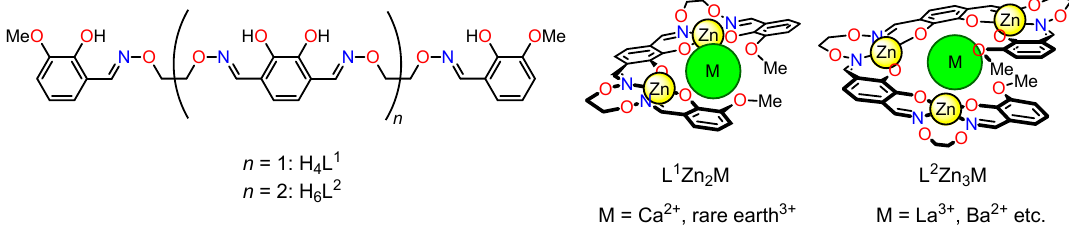
Figure 6. Oligo(salamo) ligands (H 4 L 1 and H 6 L 2 ) and molecular structures of the helical complexes (L 1 Zn 2 M and L 2 Zn 3 M).